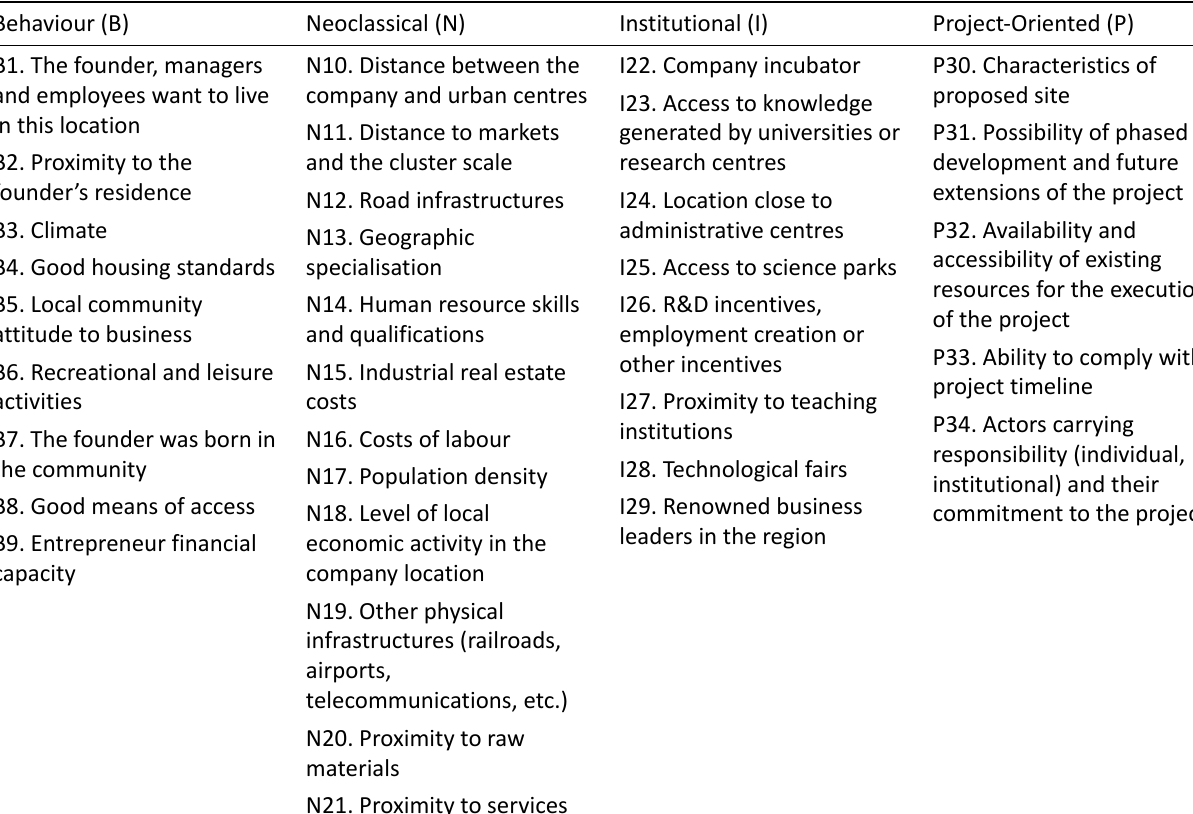
Table 4. Proposed extension.